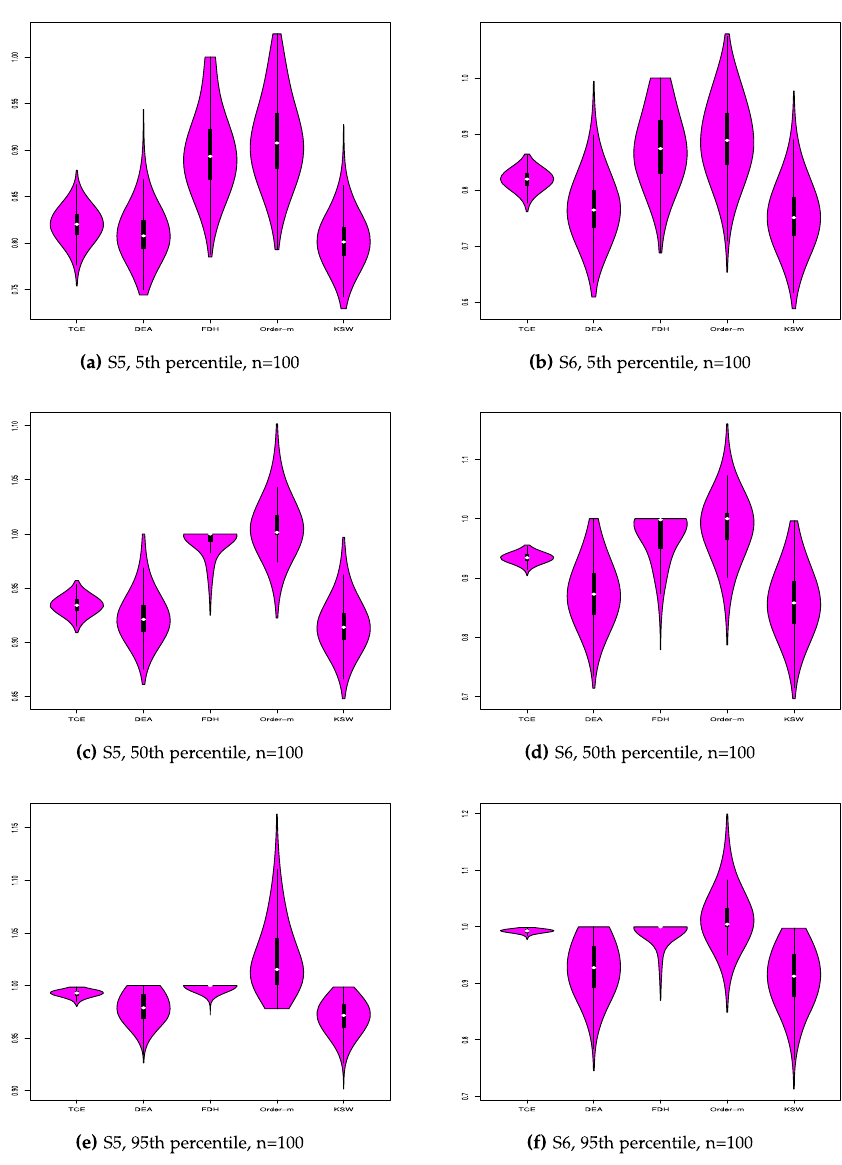
Fig. 3 Violin plots in scenario 5 and 6 for 5th, 50th and 95th percentiles of cost efficiency estimates under a Cobb-Douglas cost function mode). However, despite all methods being quite close to the TCE distribution, DEA underestimates less than KSW, and FDH overestimates less than order- m . Finally, at the 95th percentile FDH (followed by order- m ) is the best method to determine a higher number of efficient units because its mode and median values are closer to the true